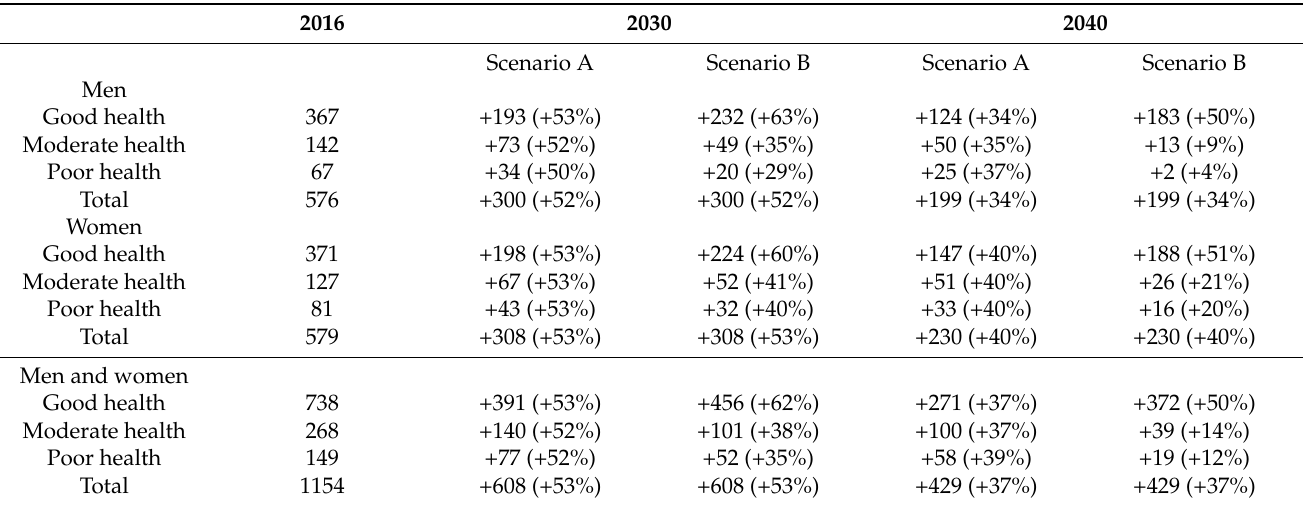
Table 3. Health distribution among men and women from age 60 up until the state pension age, in 2016, 2030 and 2040 (absolute numbers × 1000 and growth rates). 2030 2040 Scenario A Scenario B Scenario A Scenario